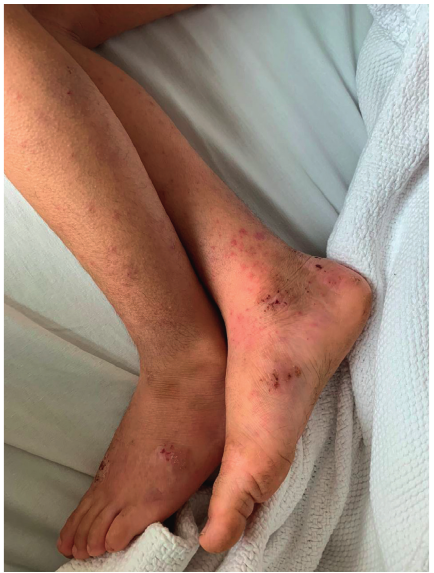
Figure 1: Case 1 shows purpura covering the legs.